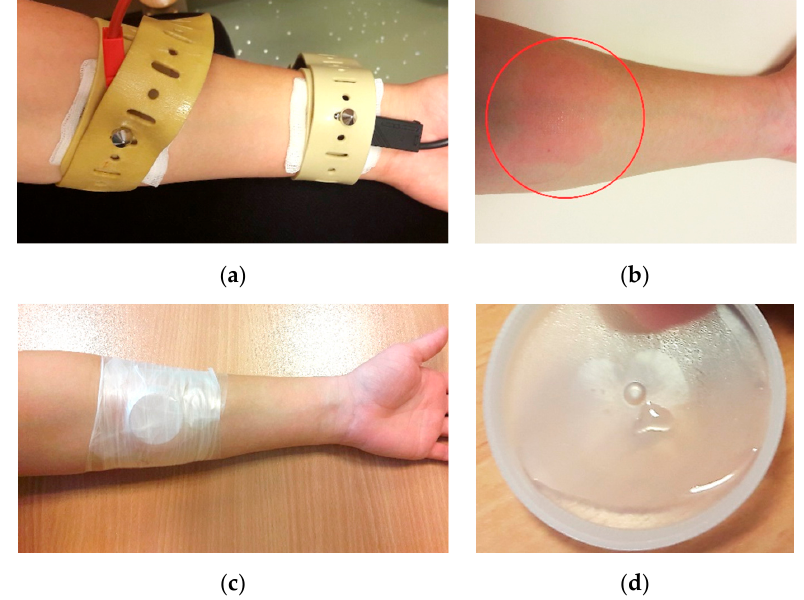
Figure 2. ( a ) Sweat inducement by pilocarpine iontophoresis using two electrodes attached to the forearm; ( b ) irritation of skin after iontophoresis due to the applied electric current; ( c ) test tube pressed onto the forearm in the former position of the pilocarpine electrode to collect sweat; and ( d ) small amount of collected sweat with test tube after pilocarpine iontophoresis.